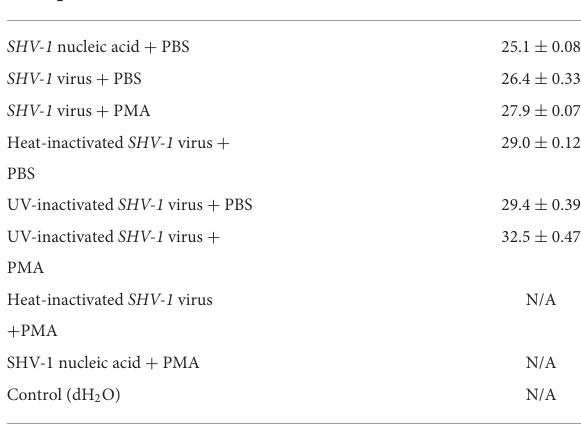
TABLE 3 PMA validity